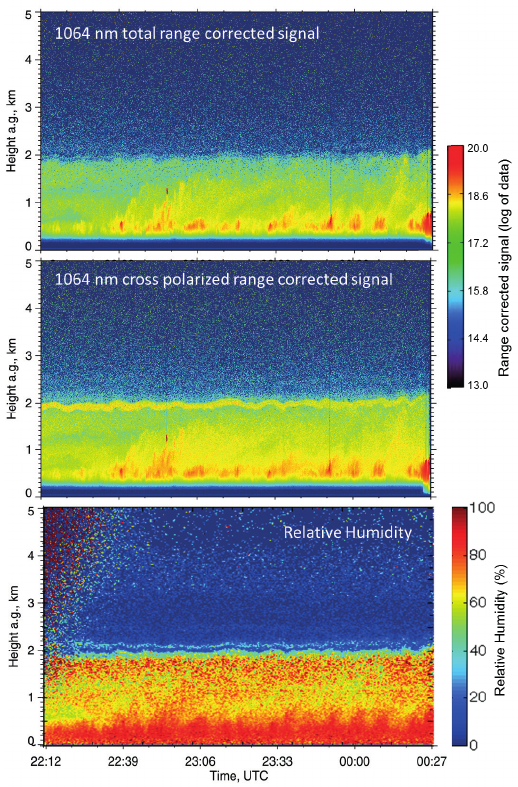
Figure 1: Range-corrected lidar signals for the 1064 nm total channel (upper panel) and 1064 nm cross polarized channel (central panel), measured at Barbados on 24 February 2014, 22:12 – 00:27 UTC. RH (lower panel) is derived from the water vapor channel (407 nm) and the temperature profile of the radiosonde (23:07